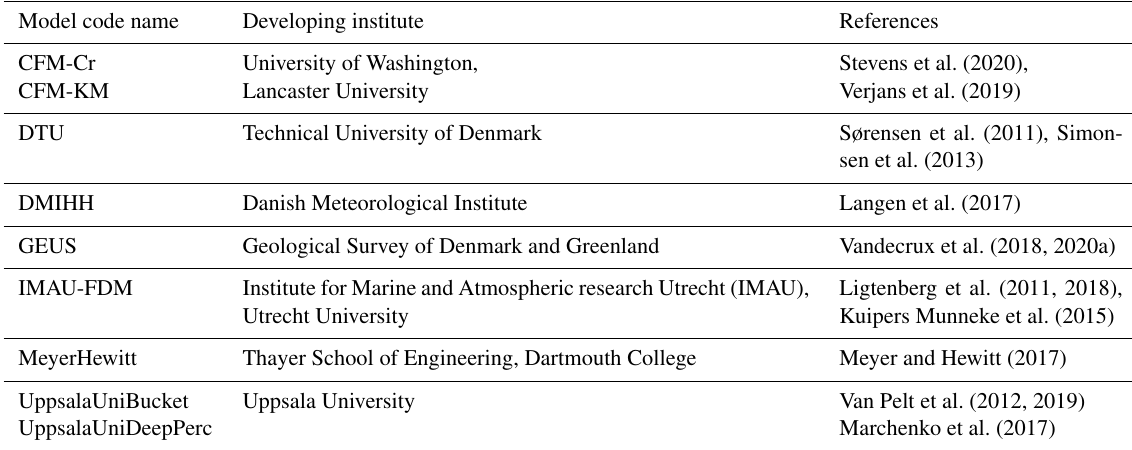
Table 1. Models evaluated in this